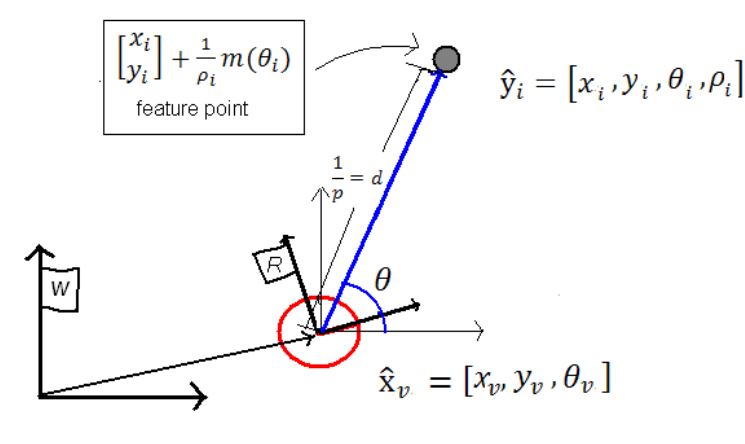
Figure 1. Inverse depth